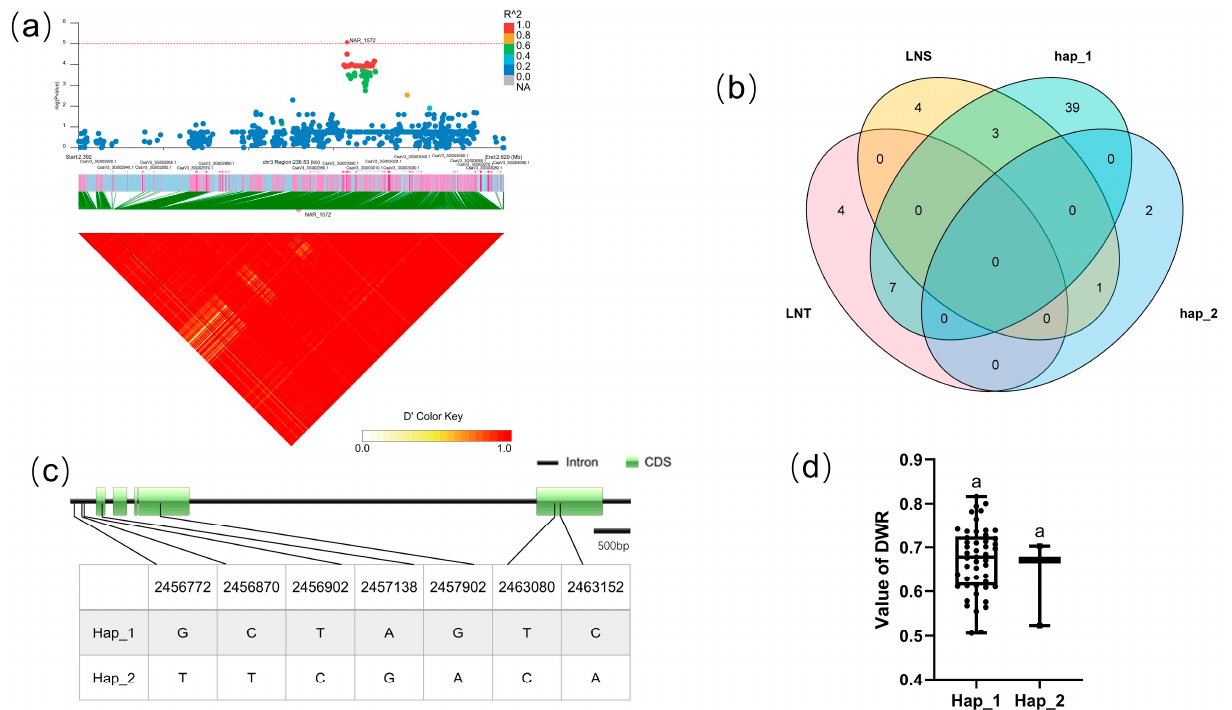
Figure 5. Identification of the low-nitrate tolerance gene at block 1572. ( a ) Manhattan map (top) and LD heatmap (bottom) of the block 1572. ( b ) Raf and Alt of CsaV3_3G002970 in LNS and LNR. ( c ) SNP variation of the candidate gene CsaV3_3G002970 among 2 haplotypes. ( d ) Haplotype difference of CsaV3_3G002970, different letters meant there was significant difference among groups ( p < 0.05).